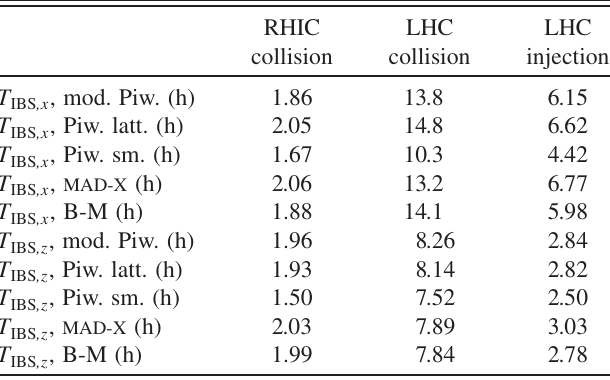
TABLE IV. IBS rise times for the emittances in RHIC and LHC, calculated using the original Piwinski model in smooth lattice approximation (Piw. sm.), original Piwinski taking the lattice into account (Piw. latt.), and the modified Piwinski method including the lattice (mod. Piw.). The calculations for RHIC are done for Gaussian bunches—these values are modu- lated for each particle by the local density in the tracking code. Results from the Bjorken-Mtingwa (B-M) method and MAD-X , used in Sec. IV, are also shown.